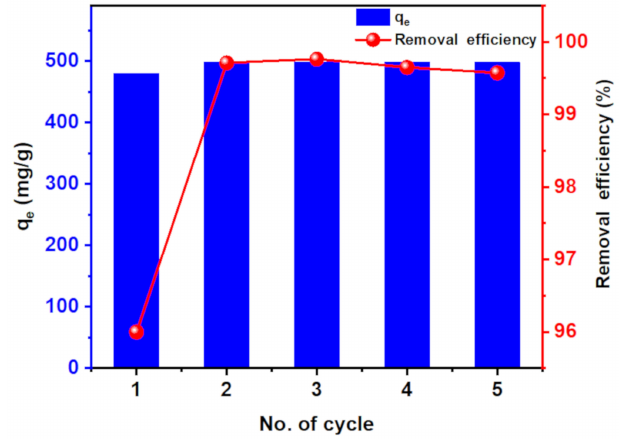
Figure 12. Five reuses of CT- g -PAA-O-ECNFs hydrogel nanocomposite.